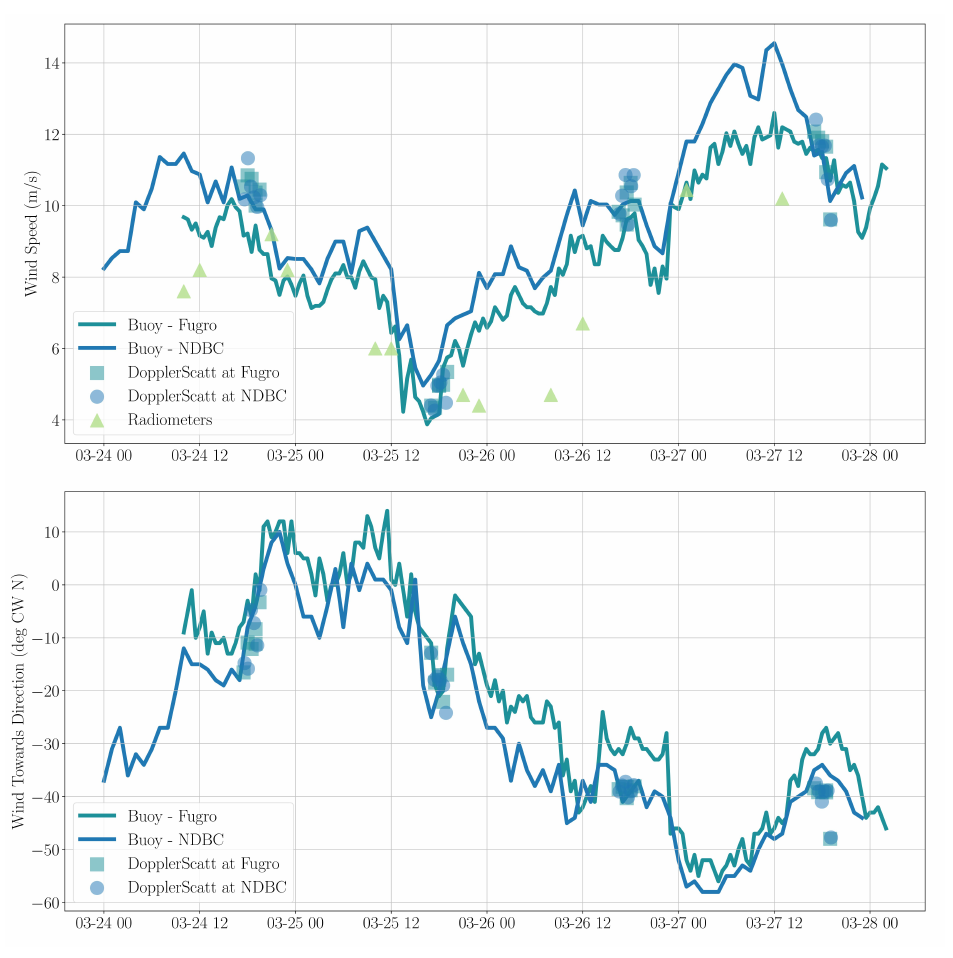
Figure 11. A time-series comparison of wind speeds ( top ) and directions ( bottom ) between collocated time series buoy measurements and DopplerScatt point measurements. Lines represent the time series of Buoy-Fugro and Buoy-NDBC wind measurements. Squares represent DopplerScatt measurements colocated in time and space to the Fugro buoy. Circles represent the same for the NDBC buoy location. Triangles represent colocated radiometer measurements which measure much larger spatial scales than